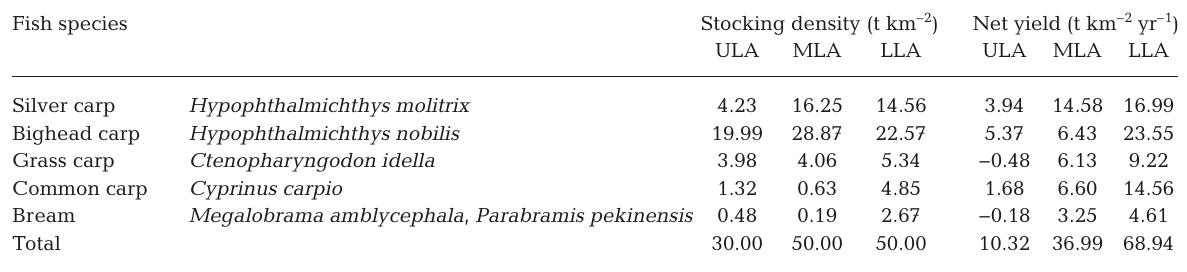
Table 1. Fish stocking density and net yield in the 3 sub-lakes of Lake Shangshe. ULA: upper lake area; MLA: middle lake area; LLA: lower lake area